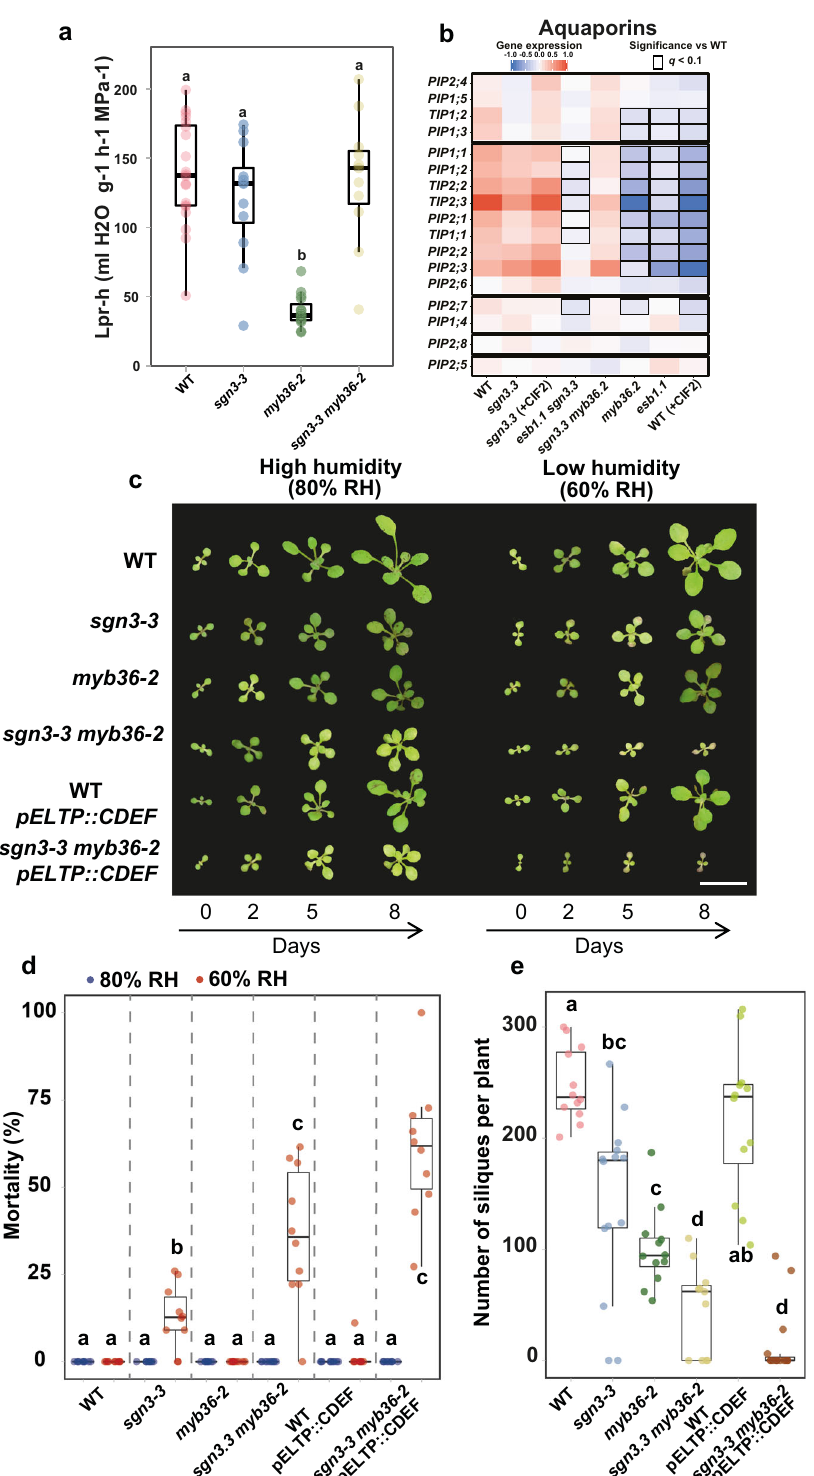
signi fi cant reduction of silique numbers is observed in all the genotypes in comparison to WT, with the exception of pELTP:: CDEF in the WT background. The sgn3-3 mutant, with a partial root apoplastic barrier defects, showed a decrease in siliques number in comparison with WT. A similar decrease was observed for myb36-2 displaying also a partial root apoplastic barrier defect and with cell-corner stress-lignin deposition. Complete disruption of endodermal ligni fi cation strongly